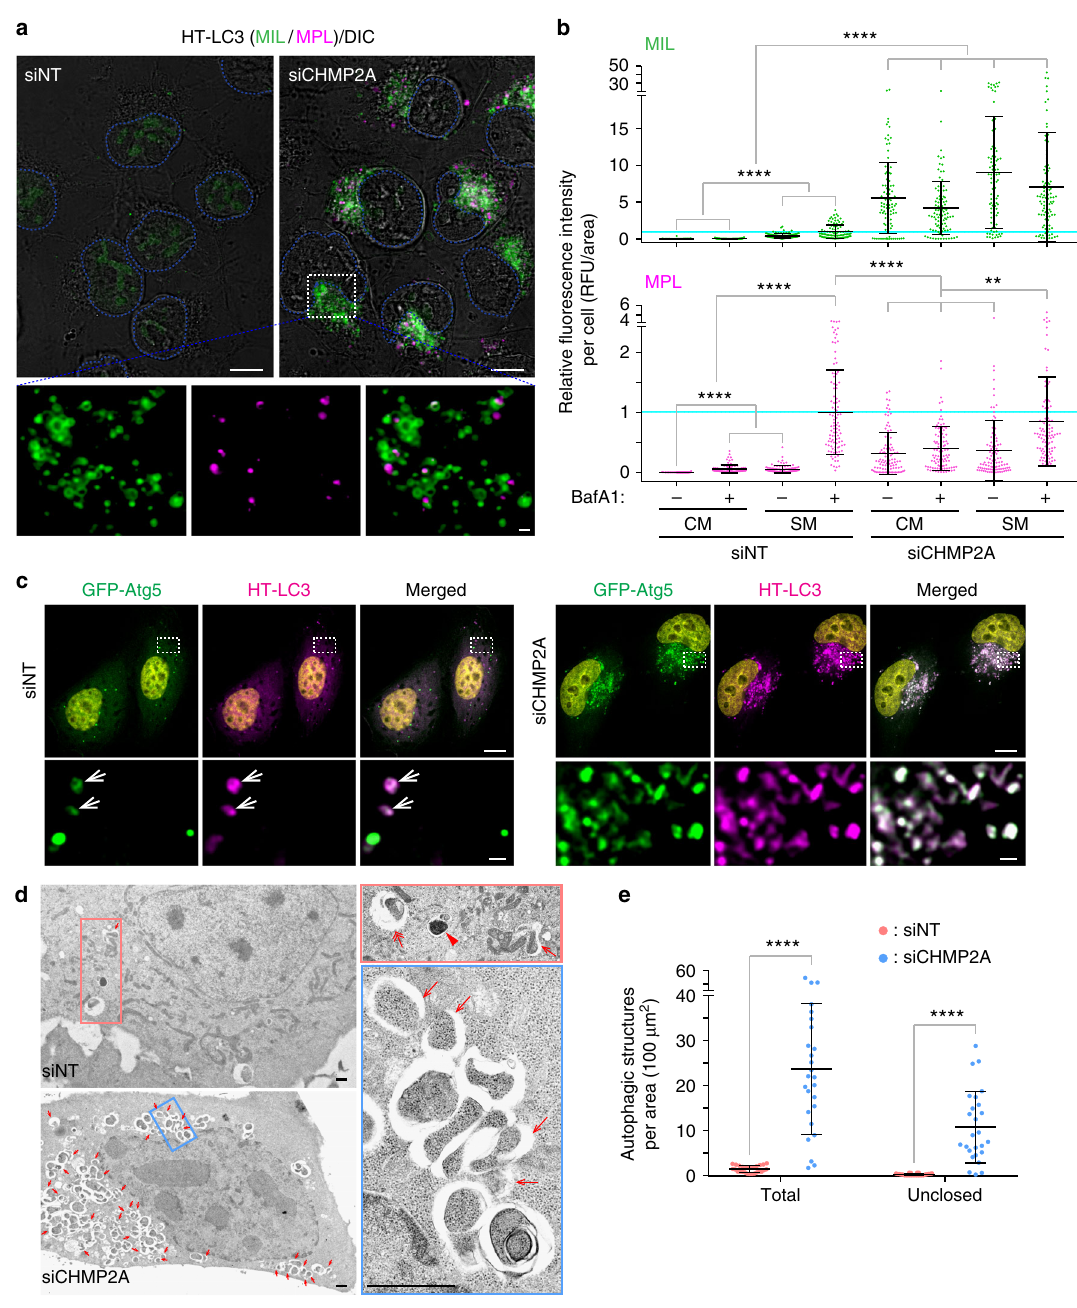
Fig. 3 CHMP2A depletion results in the accumulation of unclosed autophagosomal membranes. HT-LC3-expressing ( a ), HT-LC3- and GFP-Atg5- expressing ( c ), or parental wild-type ( d ) U-2 OS cells were transfected with the indicated ON-TARGETplus SMART Pool siRNAs for 48 h. a Cells were subjected to the HT-LC3 autophagosome completion assay followed by confocal microscopy. b Cells were incubated in CM or SM in the presence or absence of 100 nM BafA1 for 2 h and subjected to the HT-LC3 autophagosome completion assay. Representative images are shown in Supplementary Fig. 4b. The cytoplasmic fl uorescence intensities of MIL and MPL in each cell were quanti fi ed and normalized to the respective mean fl uorescence intensities of control siNT-transfected cells starved in the presence of BafA1 ( n > 100). Data shown are representative of three independent experiments. Statistical signi fi cance was determined by Kruskal – Wallis one-way ANOVA on ranks followed by Dunn ’ s multiple comparison test. All values are mean ± SD. ** p ≤ 0.01; **** p ≤ 0.0001. c Cells were stained with TMR-conjugated MPL, starved for 2 h and subjected to confocal microscopy. d Cells were starved for 3 h and subjected to electron microscopy. The samples were processed in the absence of potassium ferrocyanide. Arrows, two-headed arrow, and arrowhead indicate phagophore-like (clearly opened in 2D micrographs), autophagosome-like, and autolysosome-like structures, respectively. e The number of total and unclosed autophagic structures per cytoplasmic area in ( d ) was quanti fi ed and shown ( n = 26). Statistical signi fi cance was determined by two-way ANOVA followed by Sidak ’ s multiple comparison test. All values are mean ± SD. **** p ≤ 0.0001. The scale bars represent 10 μ m and 1 μ m in the magni fi ed